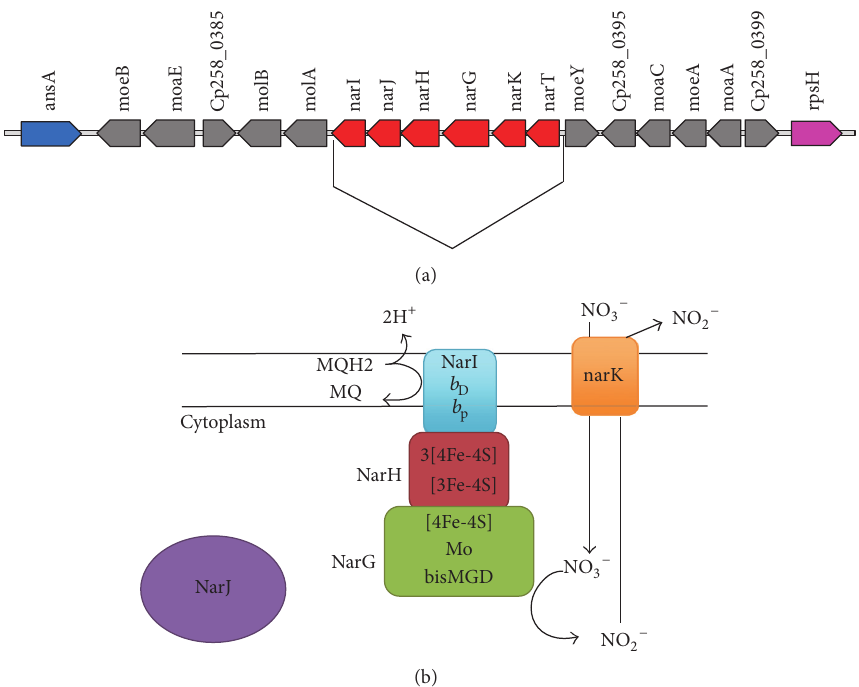
Figure 2: Nitrate locus from C. pseudotuberculosis biovar Equi. (a) This locus contains the following: genes encoding the nitrate reductase narK , narG , narH , narJ , and narI , and the genes encoding the molybdopterins moeB, moaE, molB, molA, moeY, moaC, moeA, and moaA . Insertion between ansA and rpsH : genes encoding the nitrate reductase are lacking in nitrate-negative C. pseudotuberculosis biovar Ovis strains. Arrows represent open reading frames and their orientations. (b) Bacterial nitrate respiration. The NarG and NarH bind to the membrane via the interaction between a hydrophobic patch of NarH and NarI which is buried within the membrane. The NarJis a chaperone that is involved in folding, maturation, and molybdenum cofactor insertion of nitrate